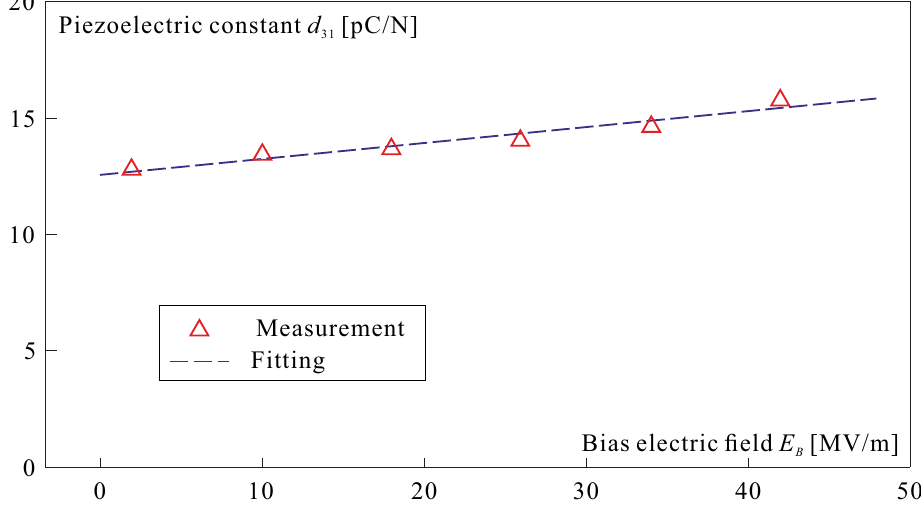
Figure 1. Piezoelectric coefficient d 31 as a function of the bias electric field E B . The electrostrictive constant Q 33 can be obtained from the slope according to Equation